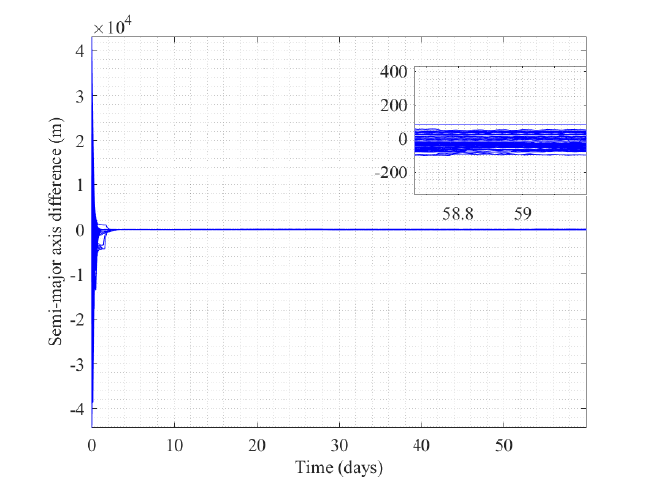
Figure 24. Minimum bound differences of constellation satellites. Red line is zero-value standard. Blue lines are minimum bound differences.